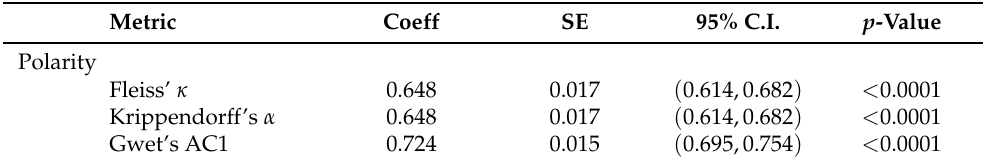
Table 3. Polarity agreement on